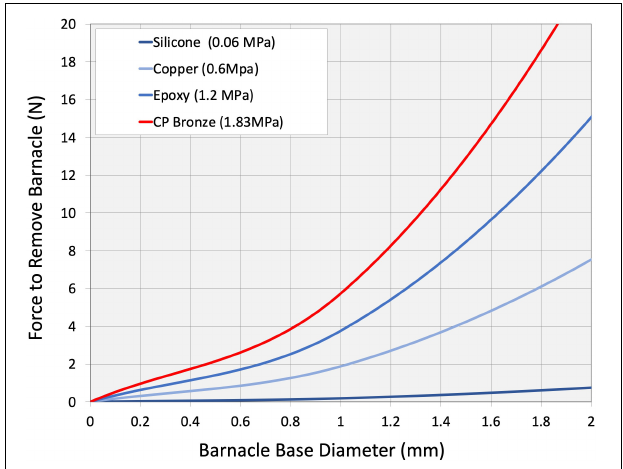
FIGURE 11 | The force required to remove a barnacle of increasing diameter from different